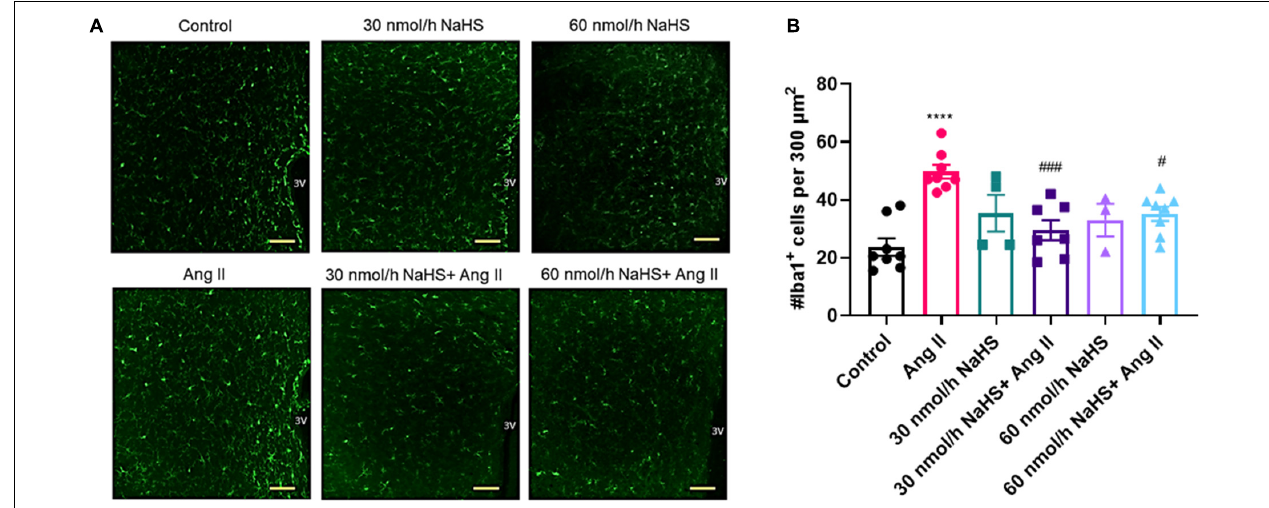
FIGURE 3 | Chronic intracerebroventricular infusion of NaHS reduces angiotensin (Ang) II–induced elevation in ionized calcium binding adaptor molecule 1–positive (Iba1 + ) cells in the paraventricular nucleus (PVN) of Sprague–Dawley rats. (A) Representative images of Iba1 + cells in the PVN in control, Ang II-treated, and NaHS/Ang II-treated rats (magnification: × 20, scale bar = 100 µ m, –0.72 mm to –1.92 mm from Bregma, Paxinos and Watson Rat Brain Atlas). (B) Quantification of Iba1 + cells per 300 µ m 2 in the PVN of control ( n = 5), Ang II ( n = 4), 30 nmol/h NaHS ( n = 3), 60 nmol/h NaHS ( n = 2), 30 nmol/h NaHS/Ang II ( n = 3), and 60 nmol/h